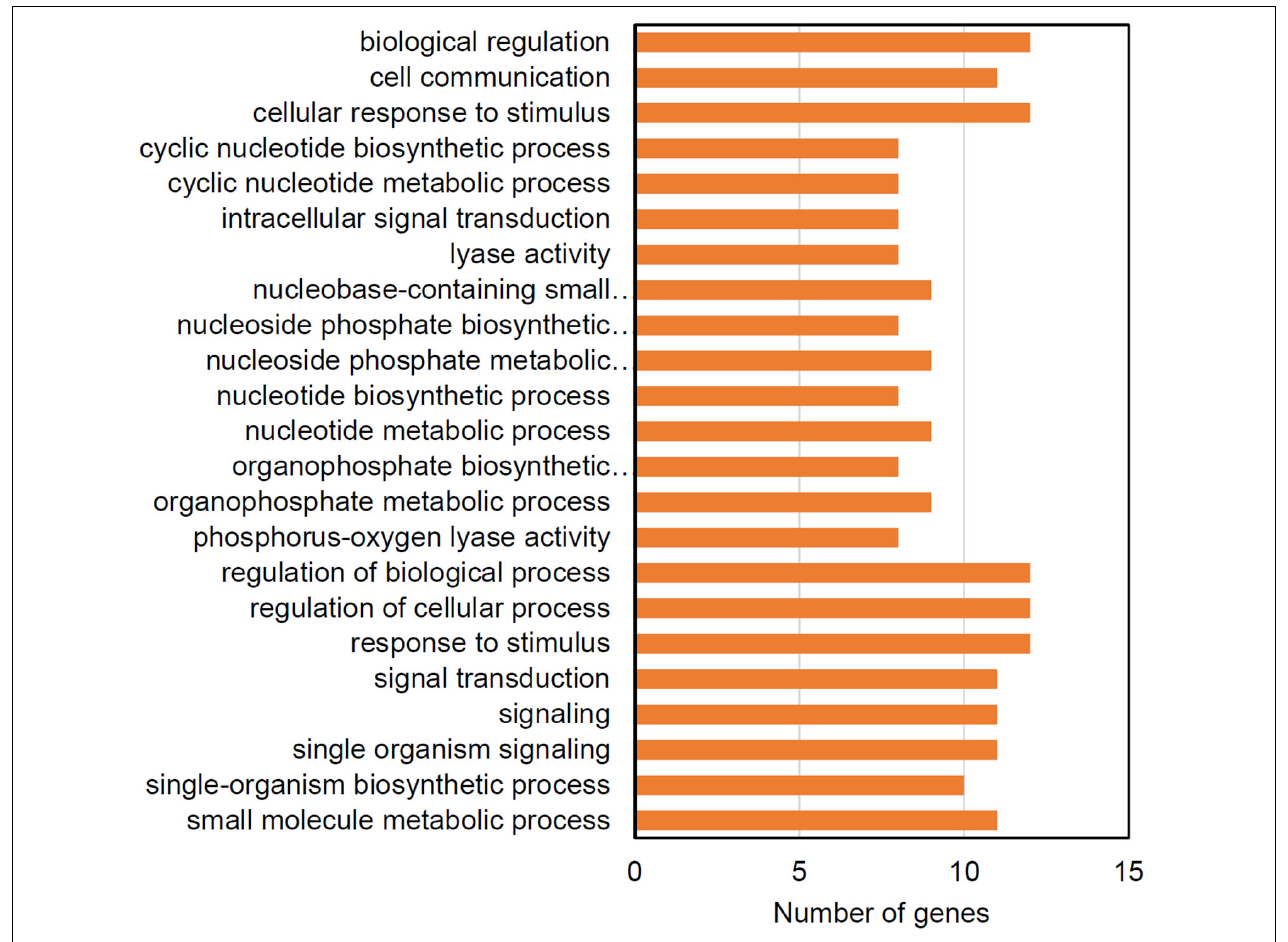
FIGURE 8 | Enriched GO terms for genes showing evidence of purifying selection in the WT